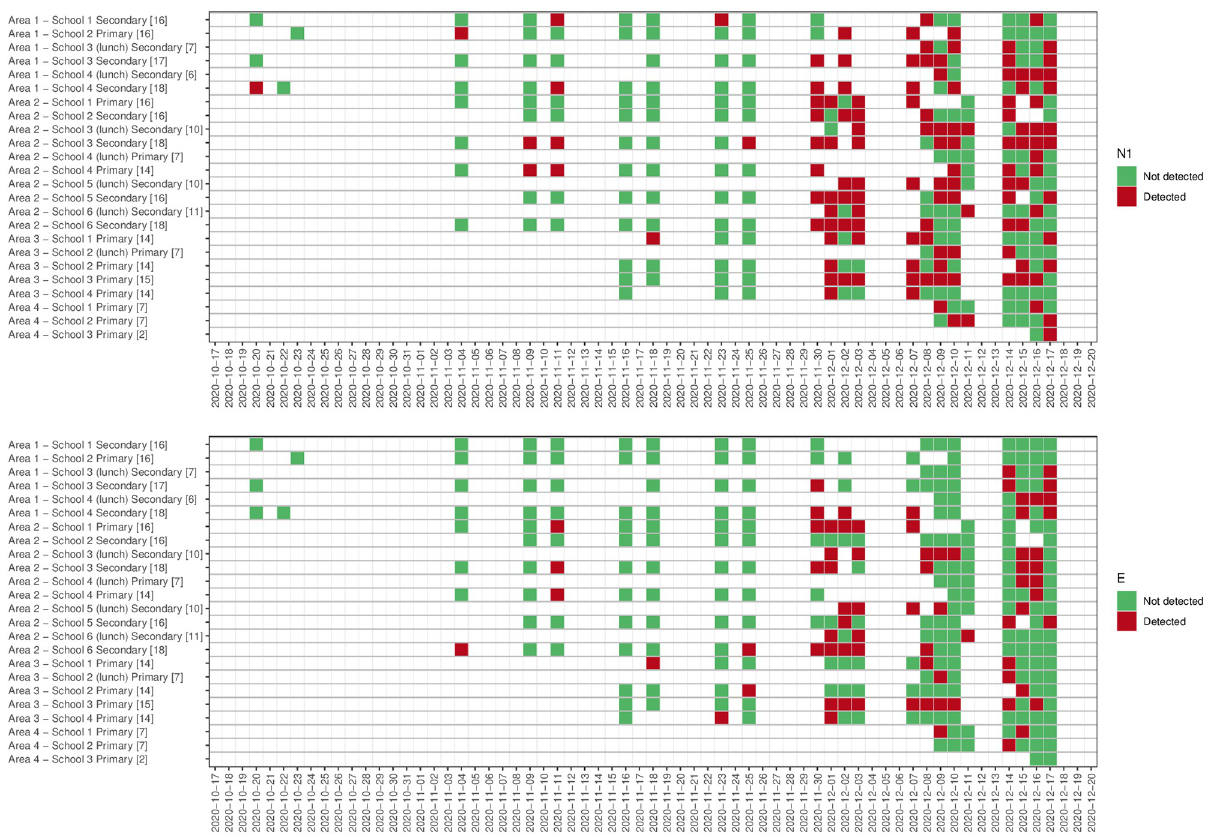
Fig 1. Heatmap detection/non-detection for N1 gene (a) and E gene (b). Note: number of samples collected for each school/sample pattern is provided in square brackets at the end of the name of the school. https://doi.org/10.1371/journal.pone.0270168.g001 for the N1 gene but not the E gene (22.2%), and 12 samples (4.0%) were positive for the E gene but not the N1 gene (Figs 1 and 2). In 42.1% of samples, a first positive detection for both genes was pre-dated by a positive detection of one targeted gene and 36.8% by a non-detection (in 21.1% of cases, no sample was collected on the sampling day before the positive case).